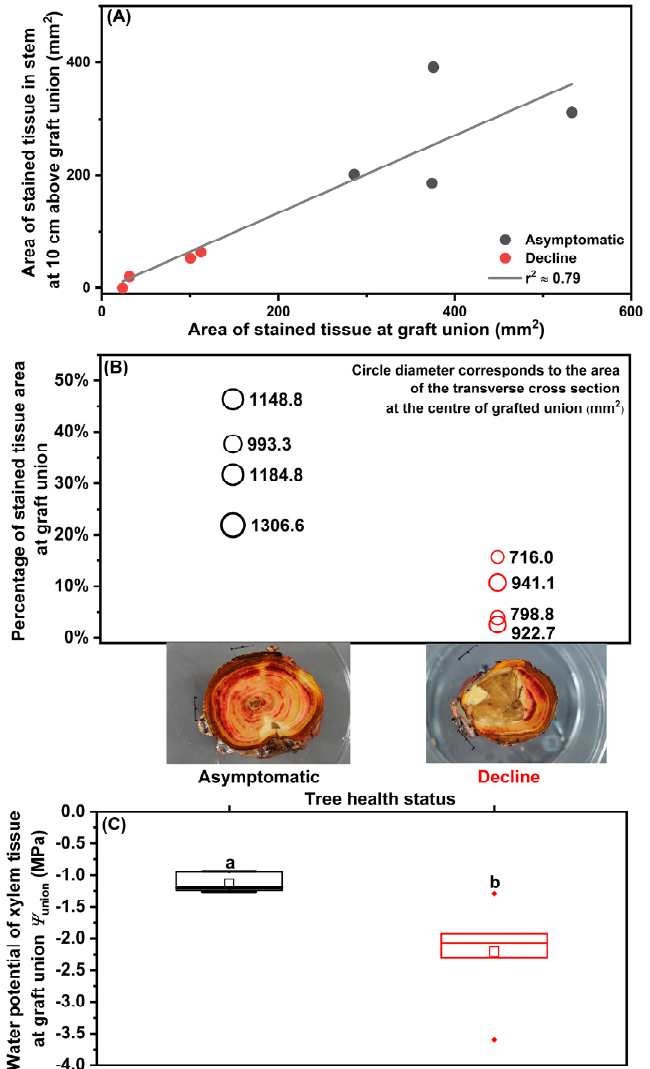
Figure 1. The hydraulic characteristics of asymptomatic and severely declining ‘Salish’/M.9 apple trees sampled from Site A in September 2019: ( A ) The area of Safranin-O stained tissue in scion cross section at 10 cm above graft union and at the center of graft union ( n = 4); ( B ) The cross section area and the percentage of stained tissue area to the total cross section area at the center of graft union ( n = 4); ( C ) Xylem water potential of graft union ( Ψ union , n = 6; one-way ANOVA, Tukey’s test, p ≤ 0.05). In ( A ), linear regression is shown as solid line; r 2 refers to the coefficient of determination for correlation. In ( C ), horizontal lines of boxplots show median and interquartile ranges, dots show outliners and squares stand for mean.